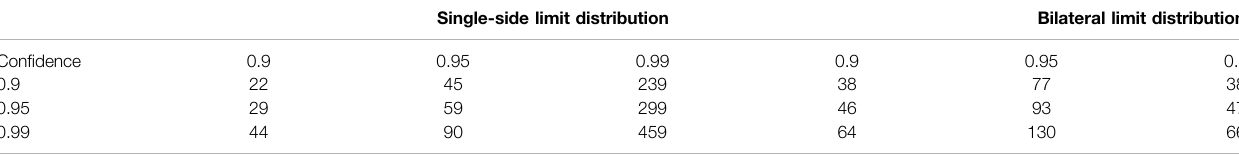
TABLE 1 | Minimum samples with different con fi dence levels and tolerance intervals.